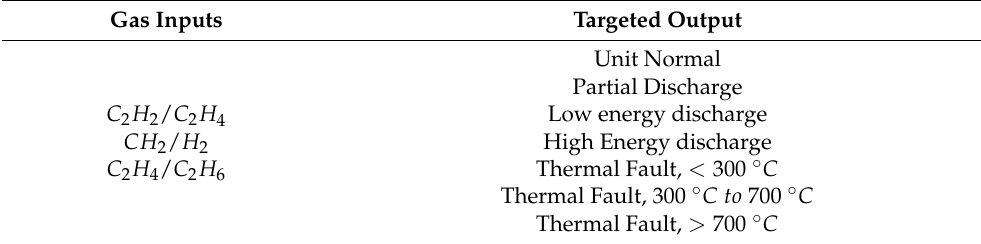
Table 2. Gas input and target response of the proposed MLANN.